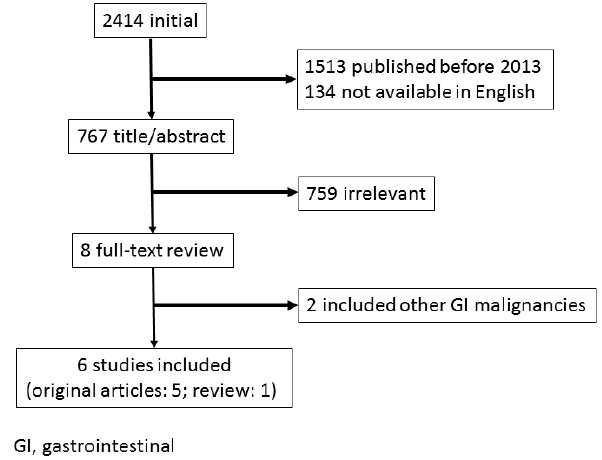
Figure 1. Study flow chart in endoscopic management for bleeding gastric cancer.